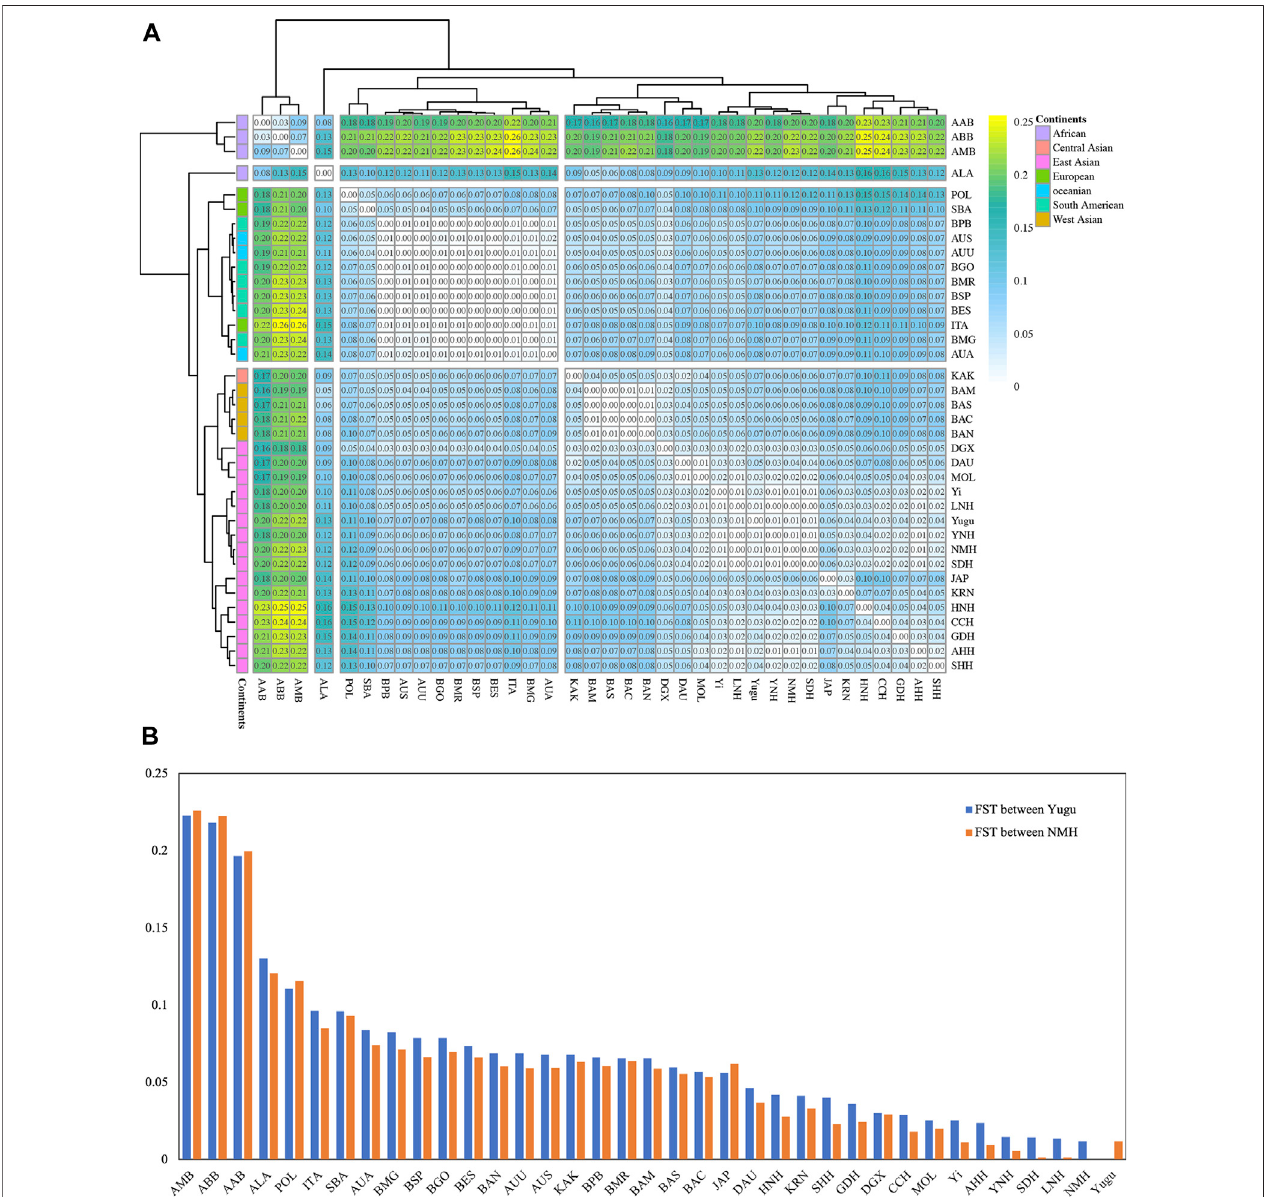
FIGURE 2 | (A) Pairwise F ST among the two studied populations and the reference populations estimated based on the Y-STR genotype data. The color gradient for the F ST ranges from white to yellow, corresponding to the F ST from low to high. At the top and left sides of the heat map, clustering trees are generated based on the F ST . (B) Pairwise F ST between Yugu and the reference populations (blue bar), as well as NMH and the reference populations (orange bar).